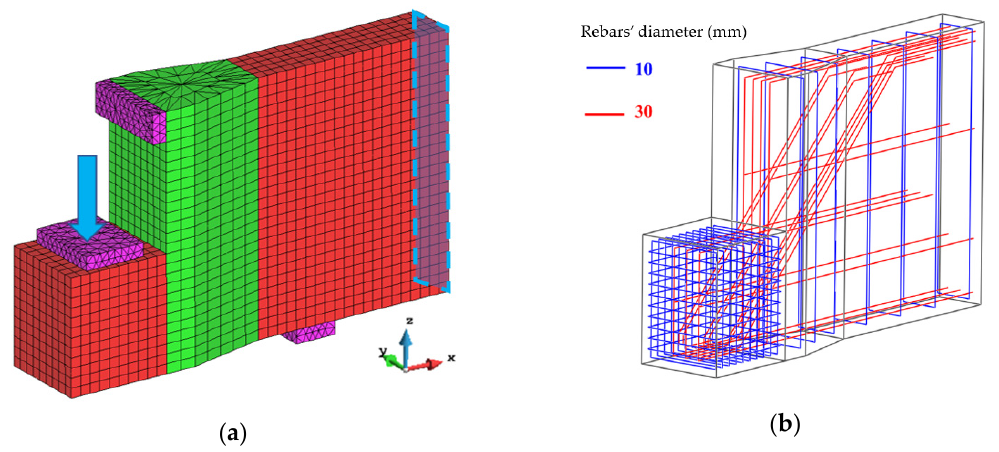
Figure 8. Finite element model: ( a ) concrete mesh and ( b ) reinforcing steel mesh.